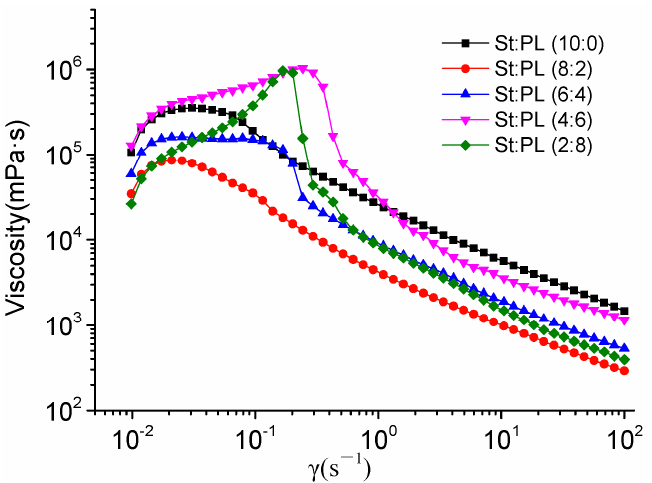
Figure 1. Rheological curves of the film solutions with different St/PL mass ratios.